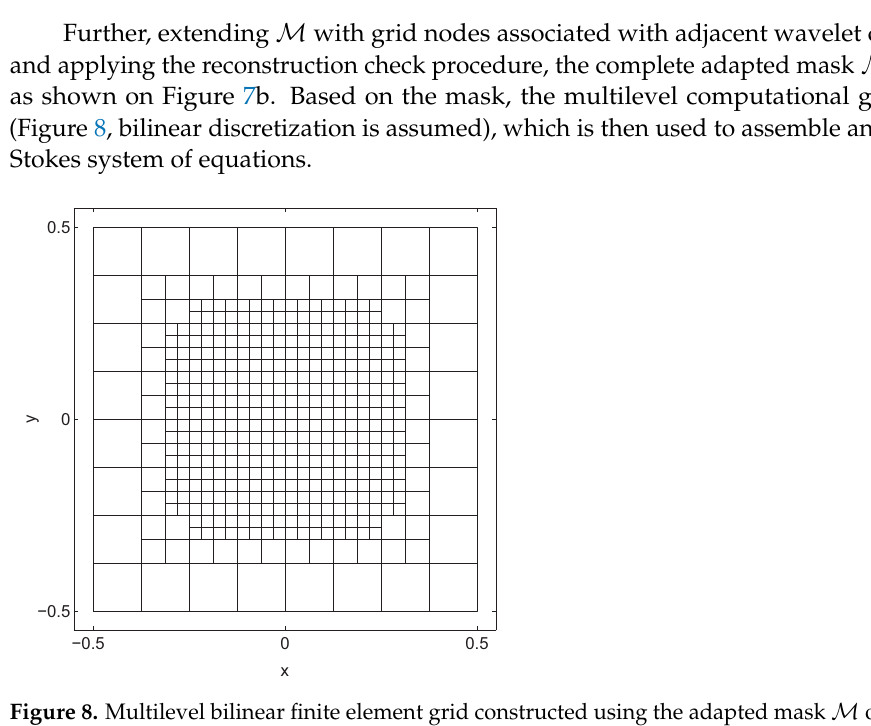
Figure 8. Multilevel bilinear finite element grid constructed using the adapted mask M on Figure 7b. Normally, the new grid is constructed in this way at each simulation time step. Note that this does not impose any changes to the particle-in-cell simulation